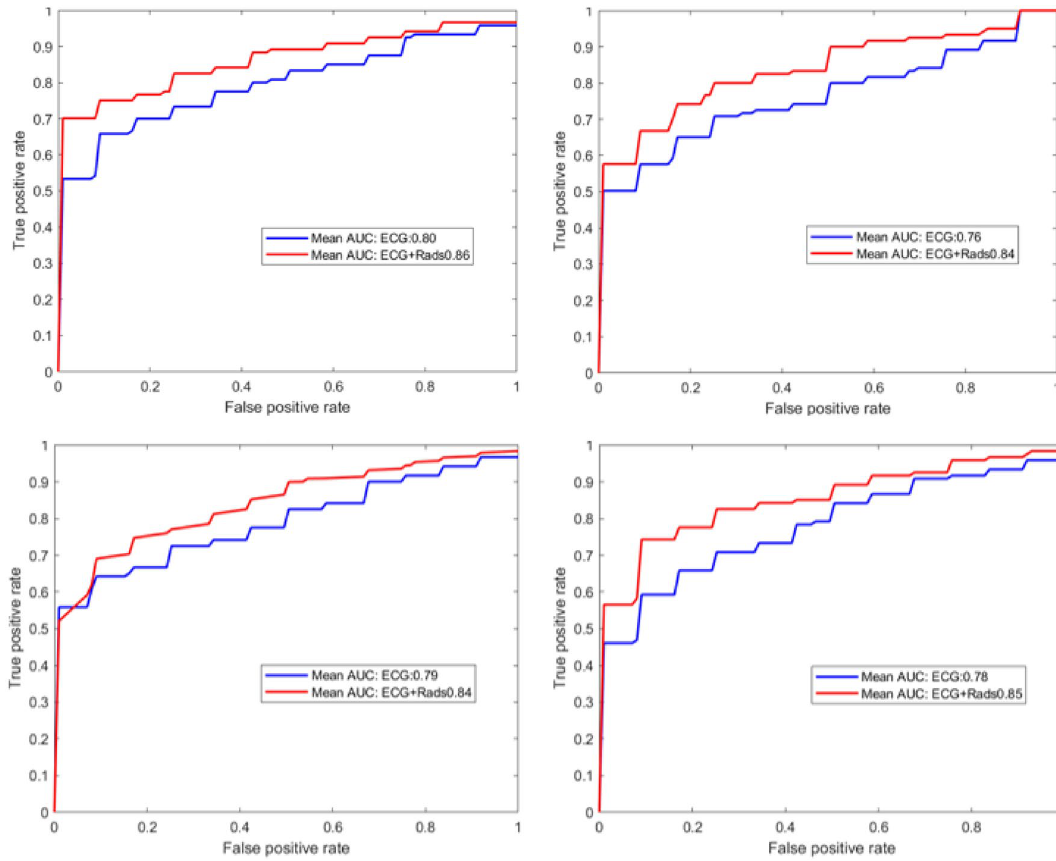
Figure 3. Different random partitions of the healthy cohort were randomly selected to show the added value of radiomics versus ECG alone in women. For all the cases, the improvement is clear and statistically significant (p < 0.05). Adjusted by sex and age (p > 0.05) Adjusted by sex and comorbidities (p > 0.05) ECG Radiomics ECG + radiomics